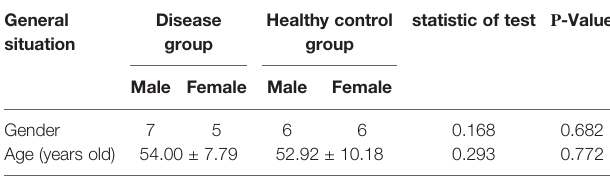
Disease Healthy control statistic of test Р group group